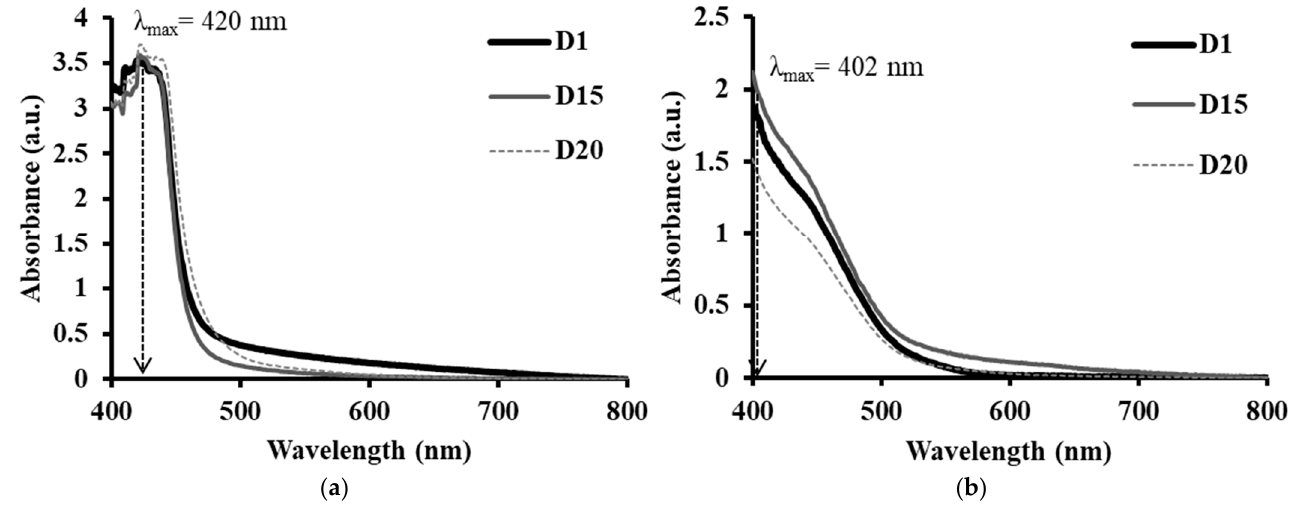
Figure 6. UV ‐ Vis spectra of ( a ) I ‐ AMP and ( b ) N ‐ AMP for D1, D15 and D20, respectively. Electronic absorption spectra of I ‐ AMP and N ‐ AMP may arise from ethylene